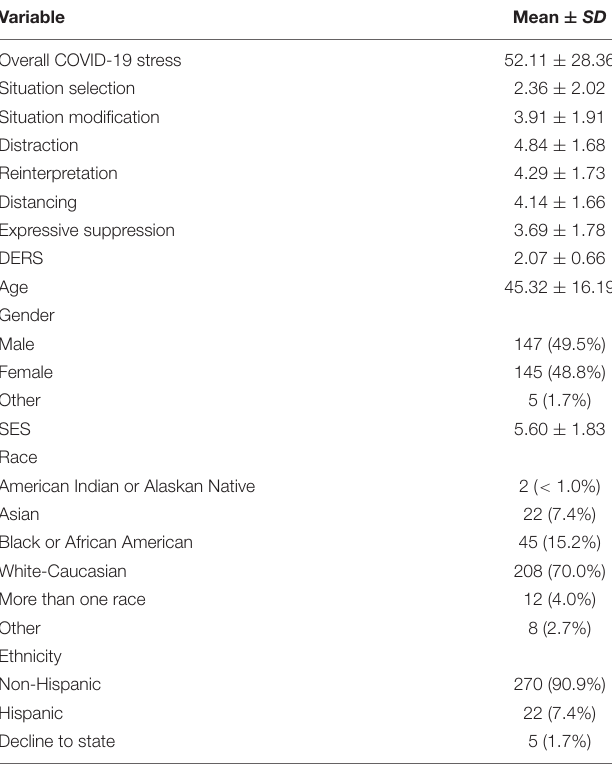
TABLE 1 | Descriptive statistics and sample